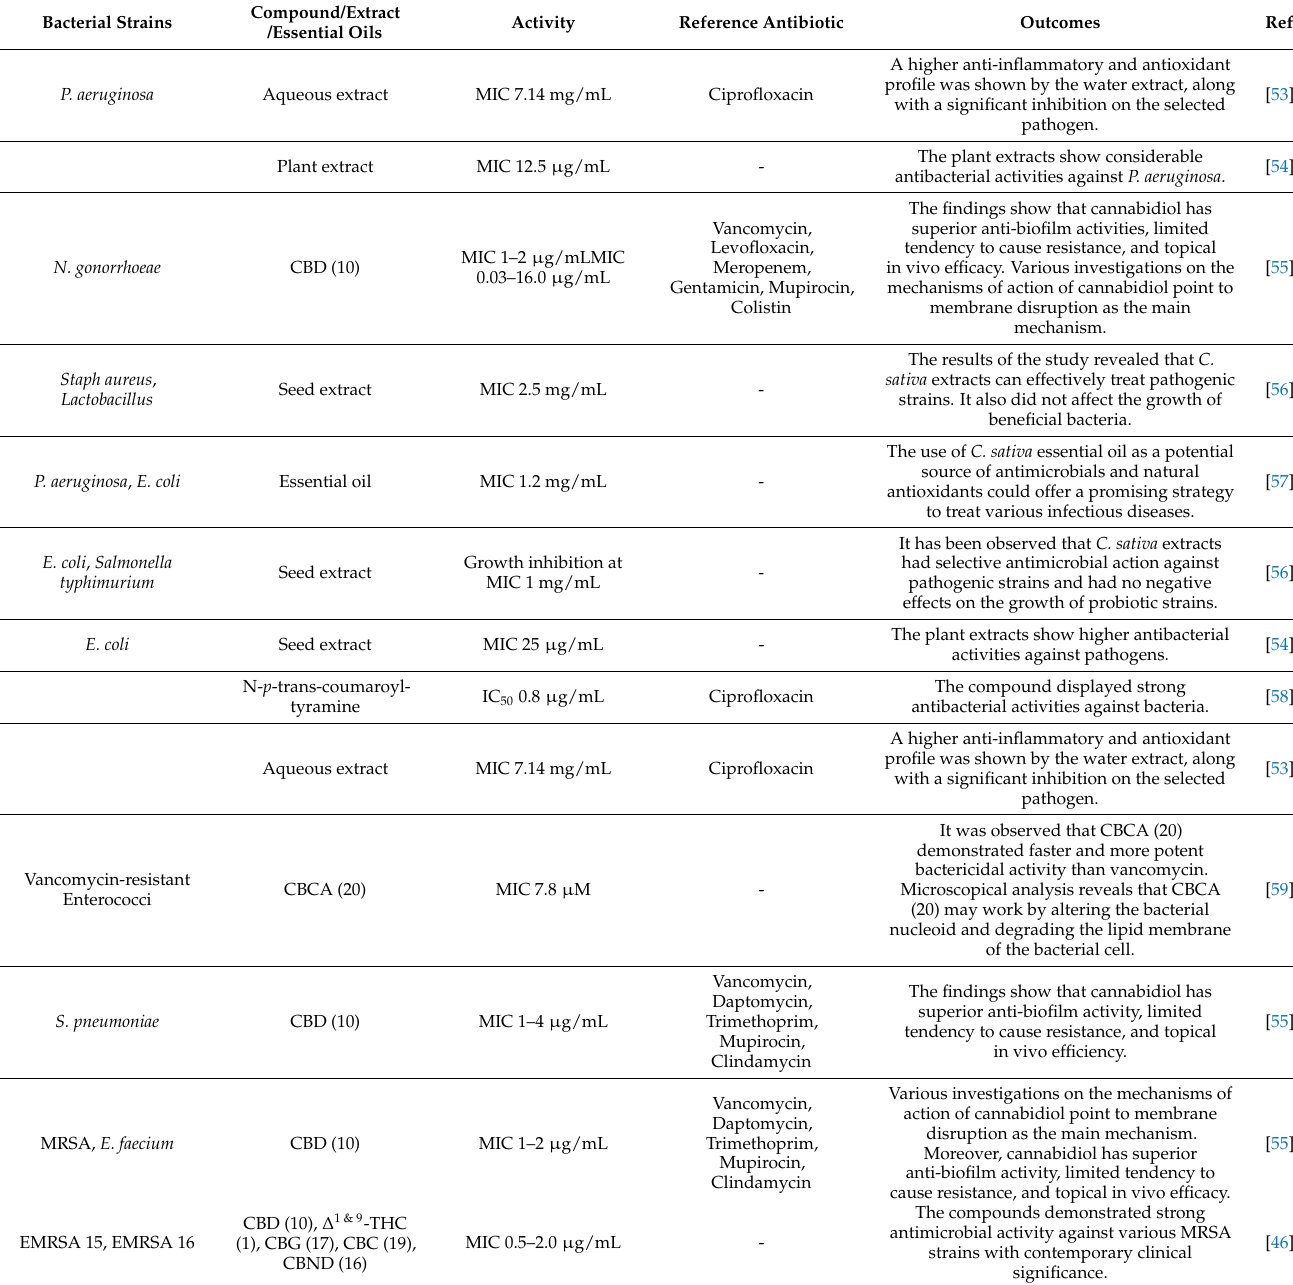
Table 1. The activities of C. sativa and cannabinoids against the pathogens enlisted in World Health Organisation’s latest priority